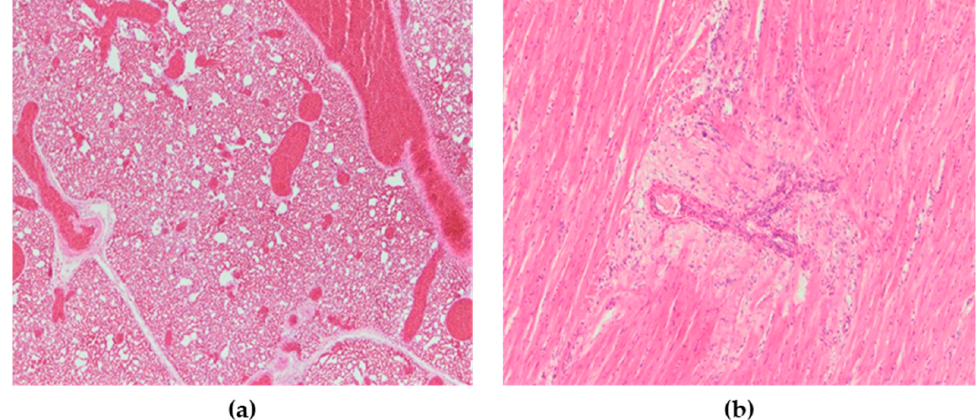
Figure 6. ( a ) Lungs, severe vascular congestion. H&E × 100. ( b ) Heart, myocardial degeneration, H&E × 200.